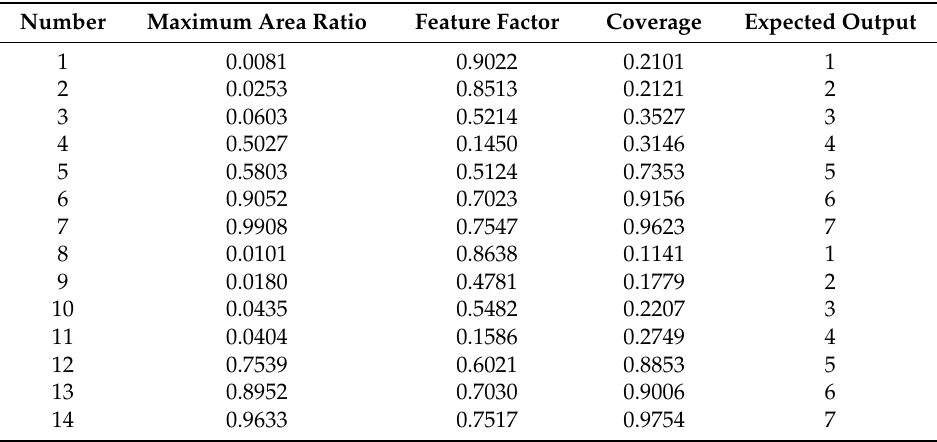
Table 3. Feature parameters of the sample data.